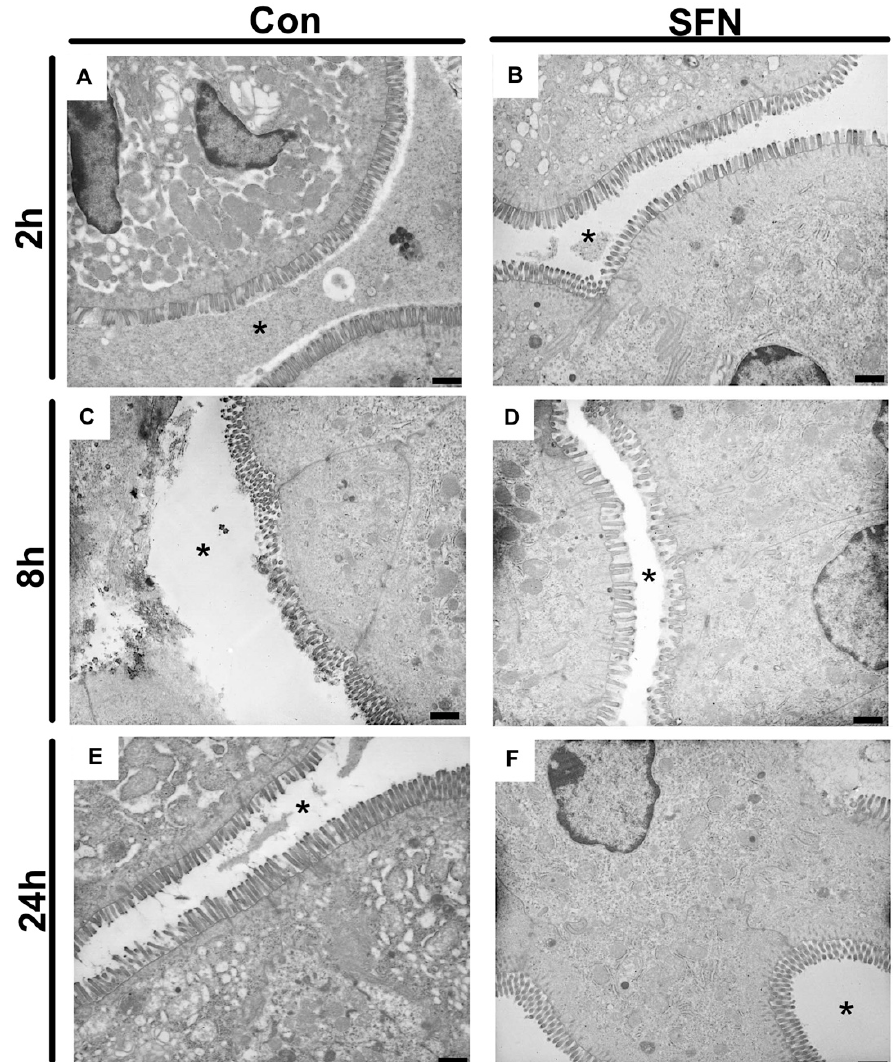
Figure 4. Representative electron micrographs of controls ( A , C and E ) and treated samples ( B , D and F ) after 2 h, 8 h and 24 h of reperfusion. * = intestinal lumen; n = nucleus; mv = microvilli. Images are representative of n = 10 analyzed animals per group and timepoint. All bars: 1 µm.